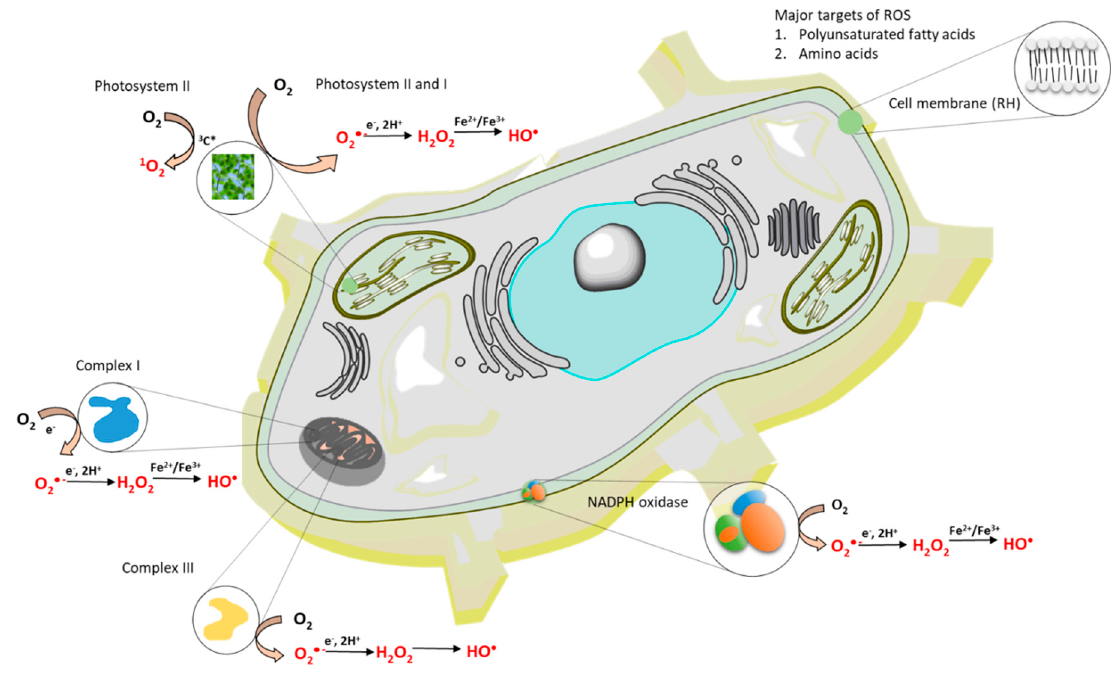
Figure 2. The formation of reactive oxygen species (ROS) within a cell. The formation of ROS occurs in mitochondria, chloroplasts and cell membrane.